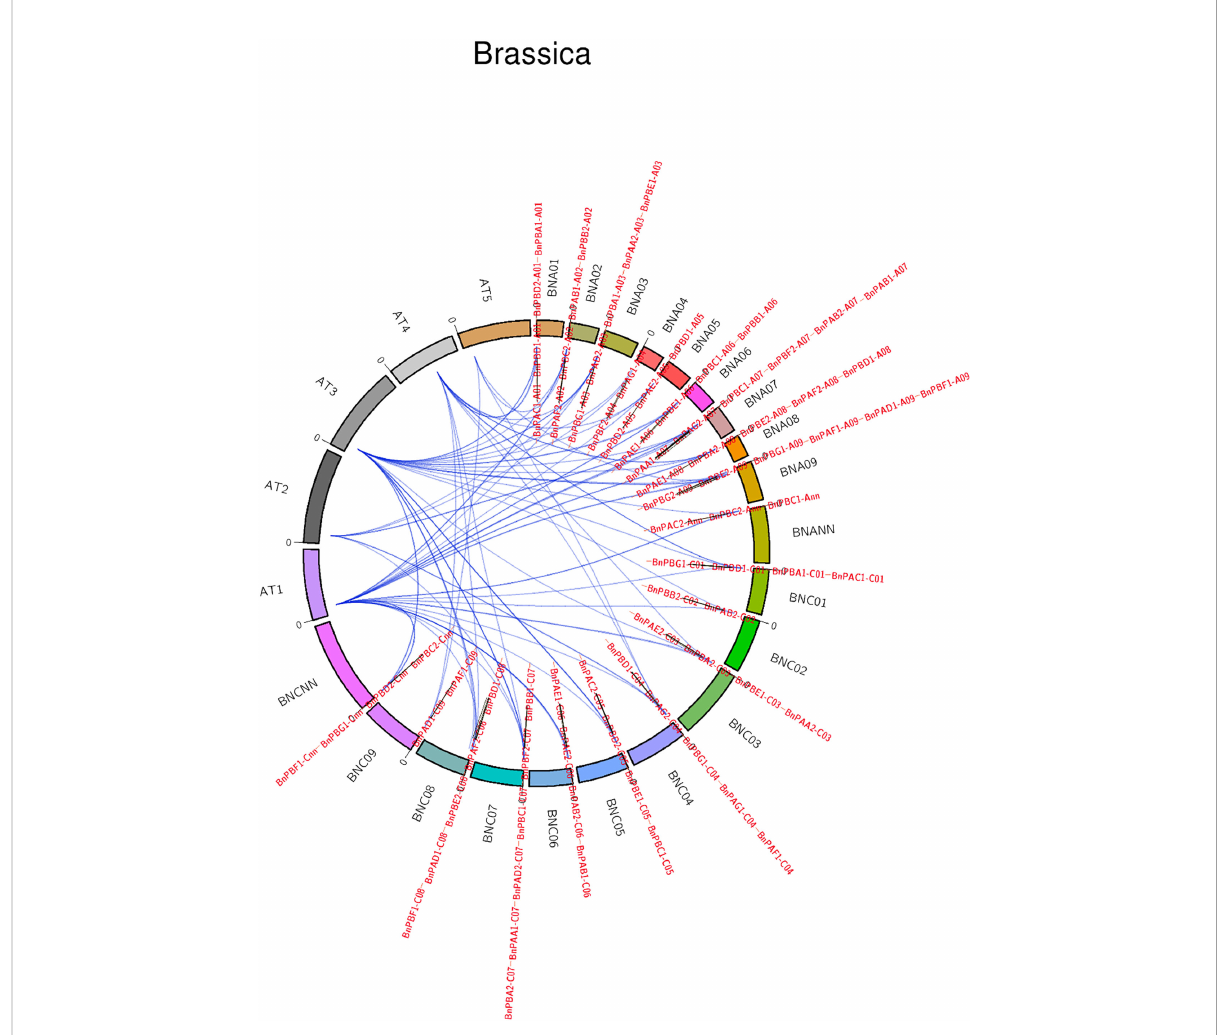
FIGURE 3 A circular map showing synteny among PA and PB genes of B. napus , A. thaliana and rice (name of chromosomes given outside the circle, name of genes given outside and inside the